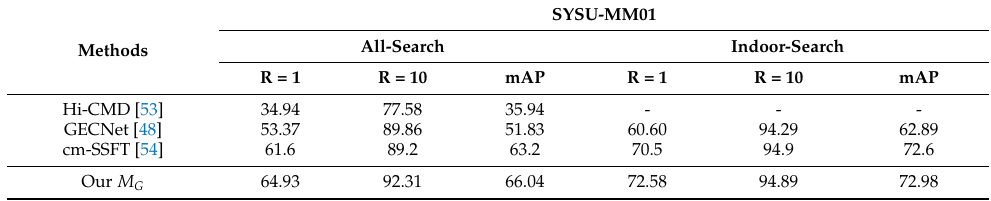
Table 7. Cross-Modal Comparison on